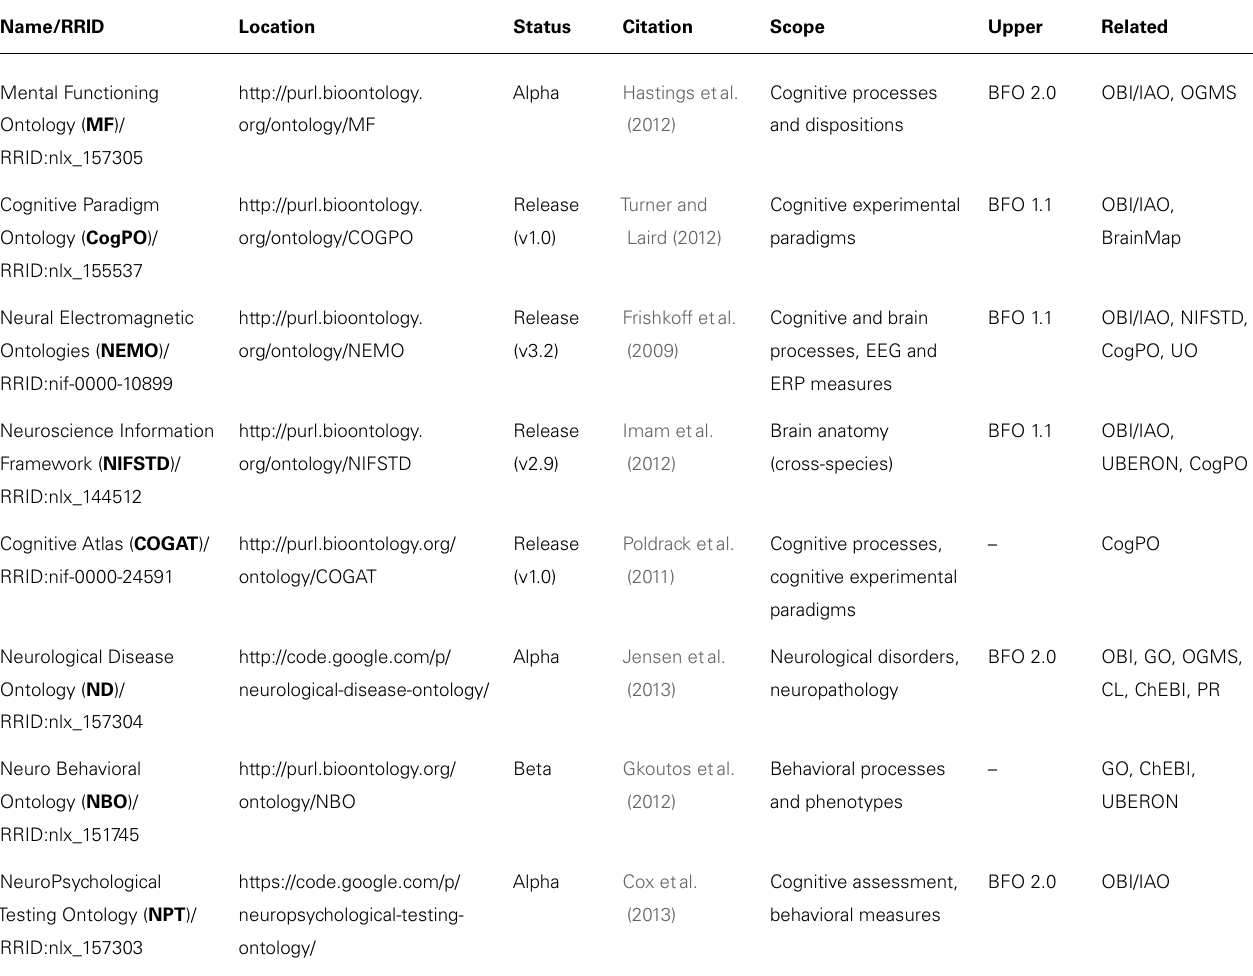
Table 1 |An overview of ontology efforts for cognitive processes and related